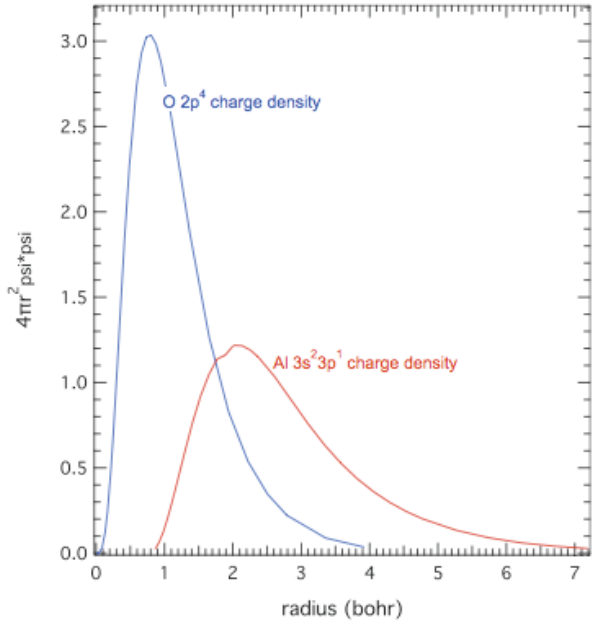
Figure 4. Spherically averaged atomic electron densities versus radius for O 2p 4